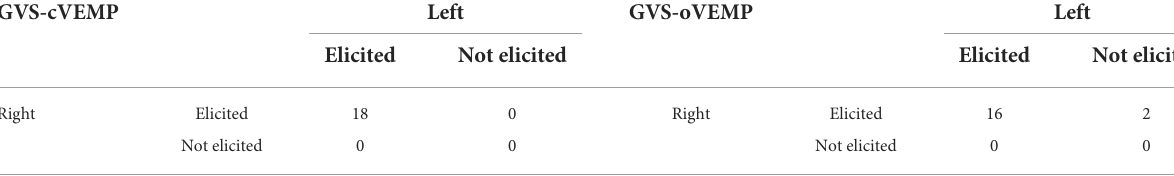
TABLE 3 Response rates of GVS-cVEMP and